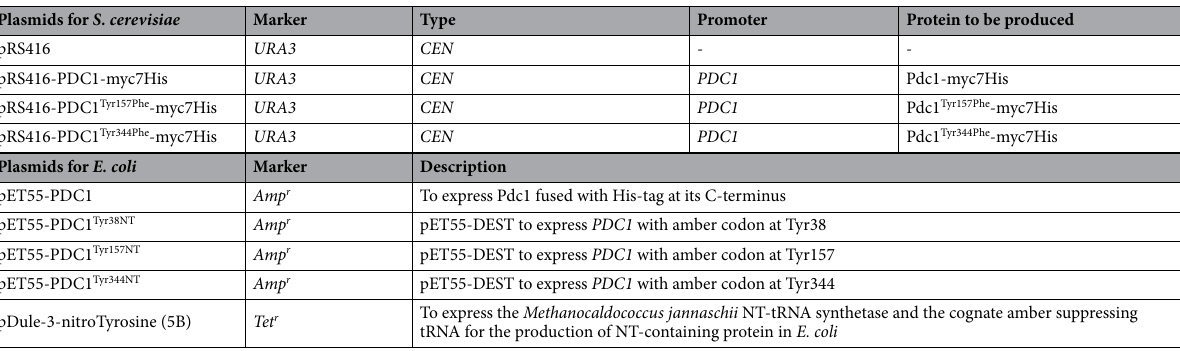
Table 3. List of plasmids used in this